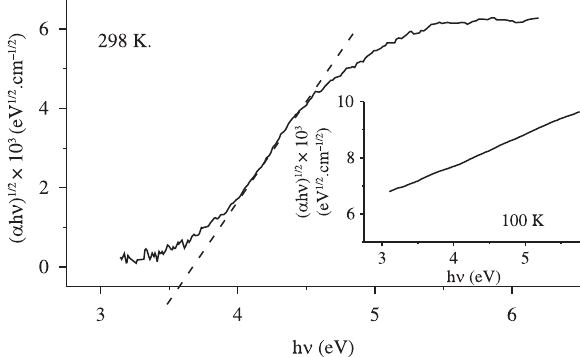
: a) bulk; c) surface (110); and e) surface (101). Brillouin Zone for SnO 2